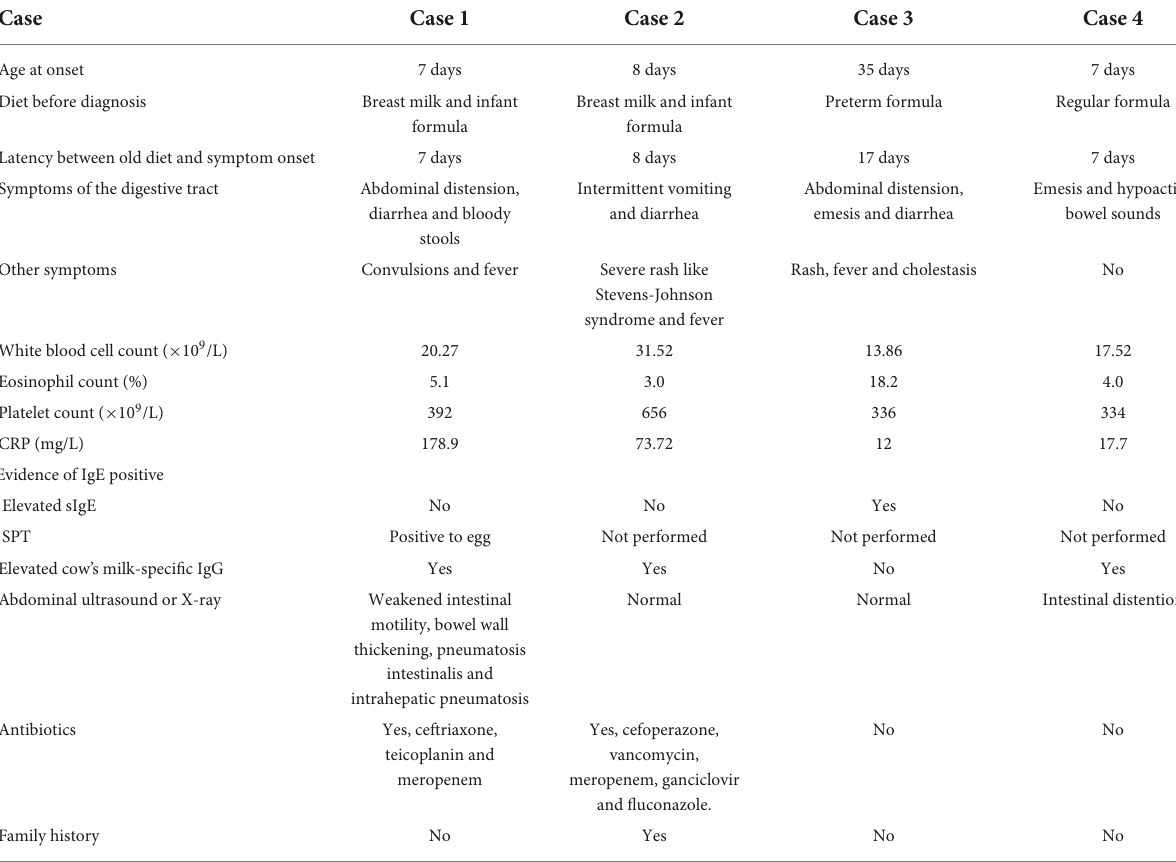
TABLE 1 Summary of case